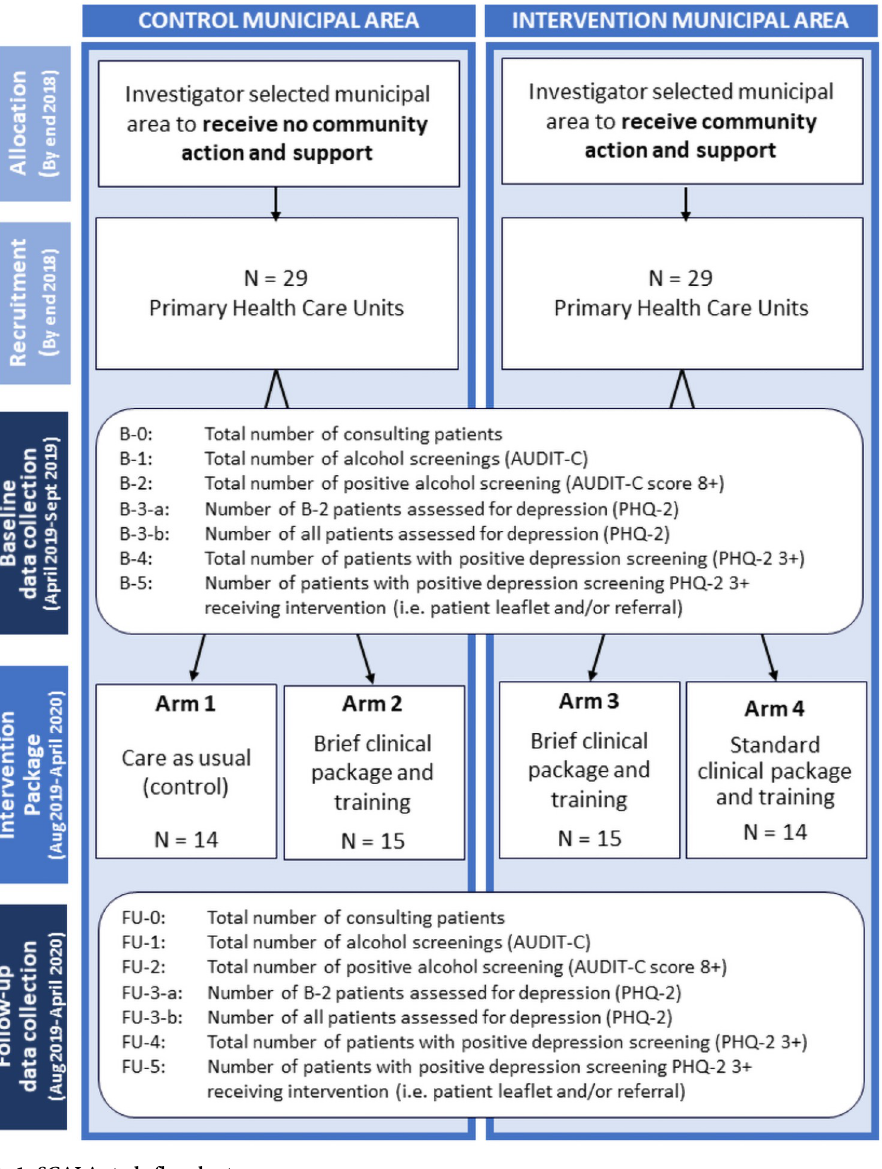
Fig 1. SCALA study